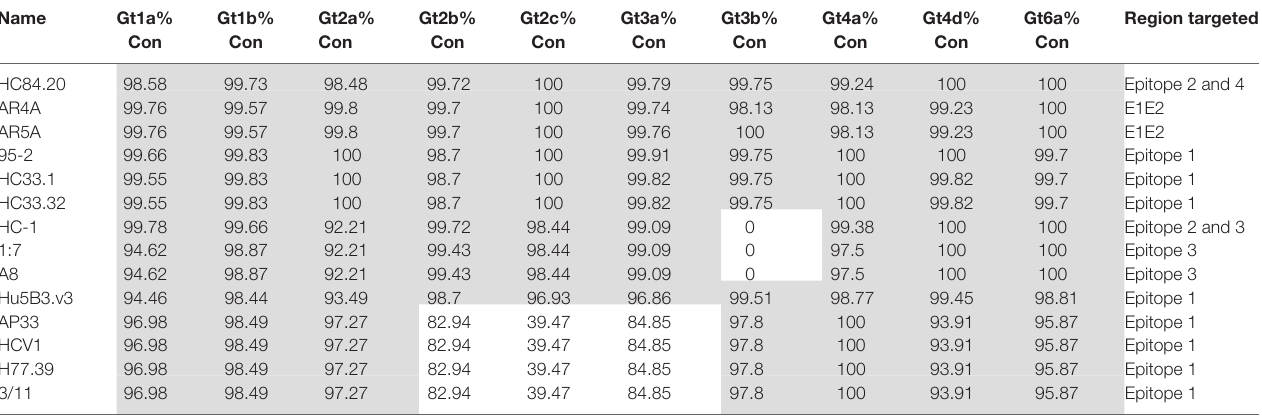
TaBle 3 | The lowest level of conservation (%) for each bNAb epitope-binding motif across subtypes.